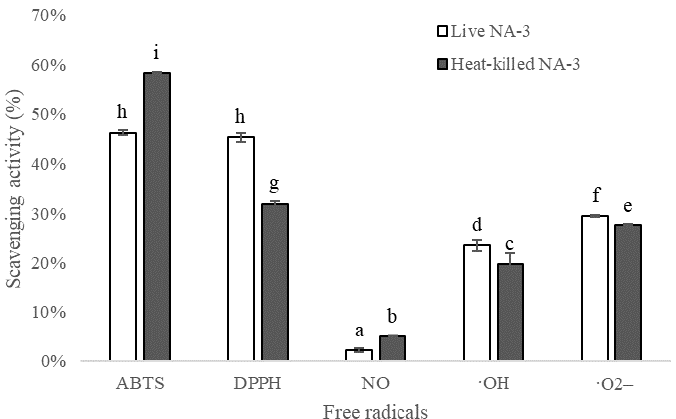
Figure 5. Antioxidant activity of live and heat-killed Loigolactobacillus coryniformis NA-3 evaluated by